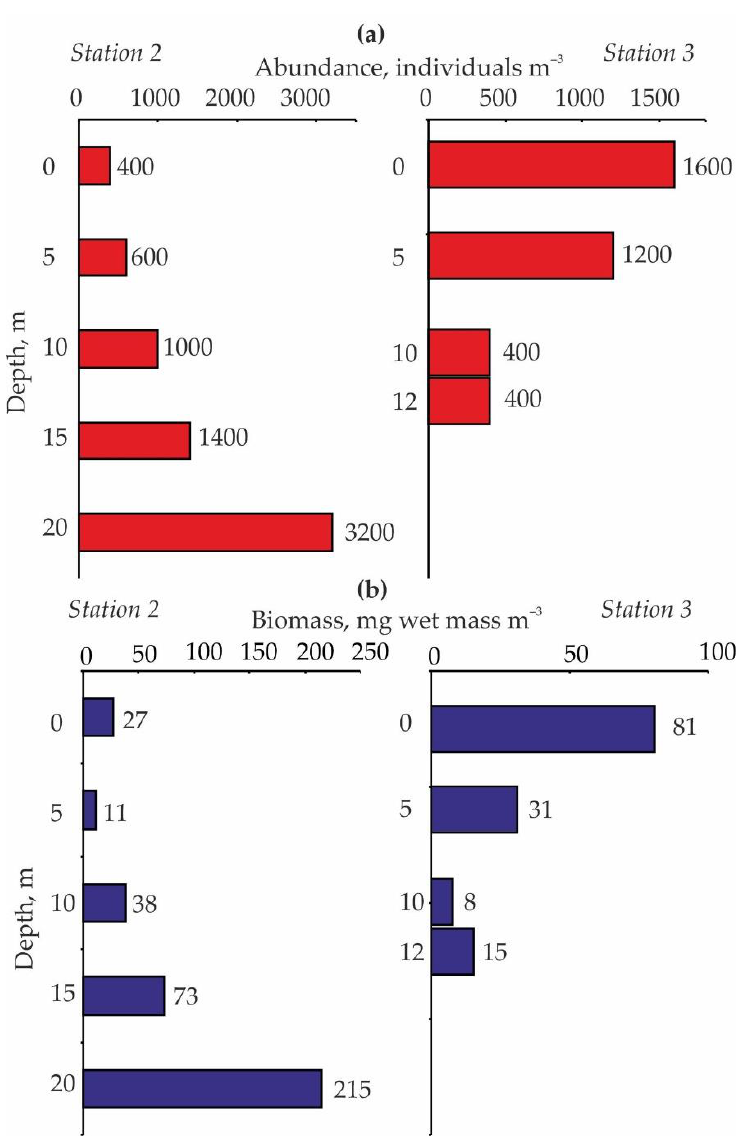
Figure 4. The vertical distribution of zooplankton abundance, ind. m − 3 ( a ) and biomass, mg wet mass m − 3 ( b ) in Lake Kulonga in March 2016. The highest abundance of zooplankton at Station 2 was recorded near the bottom (3200 ind. m − 3 ). There was a declining trend in the total number of zooplankton from the bottom to the surface with a minimum (400 ind. m − 3 ) in the upper layer (Figure 4). In